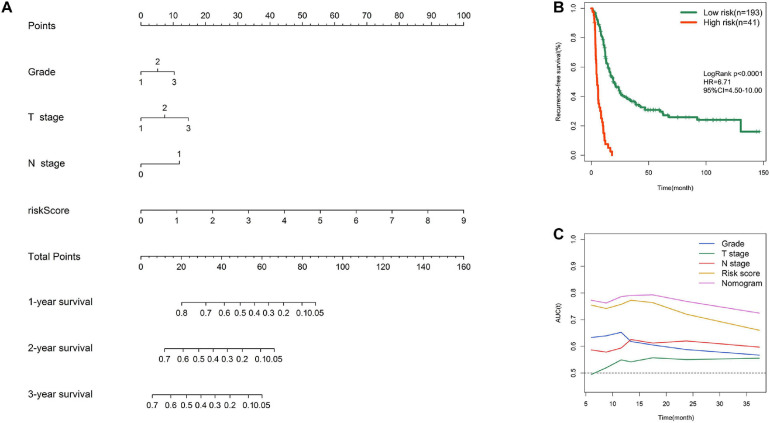
Nomogram construction. (A) Nomogram integrating risk score, grade, T stage, and N stage for RFS prediction. (B) K–M survival curve of nomogram in MTAB-6134 cohort. (C) Time-dependent AUC curves of prognostic indicators in MTAB-6134 cohort.